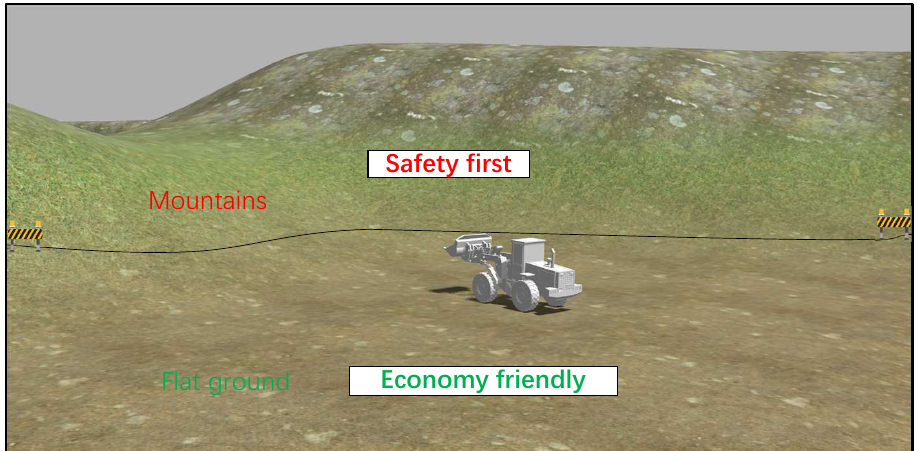
Figure 1. Environment based optimization. Mobile machines perform tasks more efficiently or safer according to their location and surroundings information. The short-term goal of SLAM is to prevent construction machinery from always working in low-efficiency areas for safety reasons, whereas the long-term goal is to increase the productivity of the working site with the help of path planning. The study focuses on affordable SLAM technology for construction machines. This work is also presented in my thesis